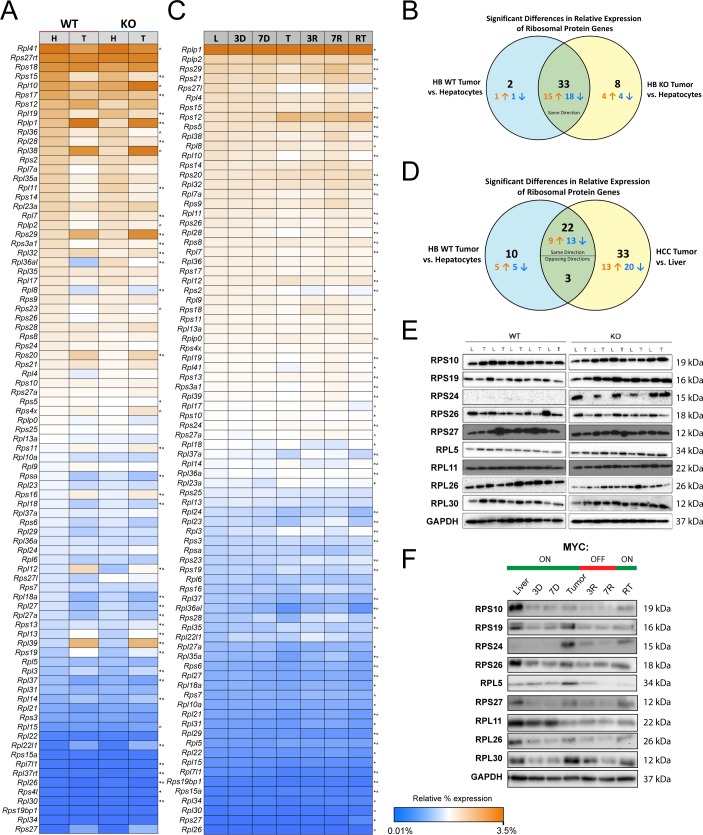
Relative RP transcript and protein levels differ in murine models of HB and HCC.(A) RP transcript abundance in hepatocytes (H) versus HB tumors (T). Heat maps are based on averaged RNA-seq data from 4–5 samples in each group with the most abundant transcripts being shown in orange and the least abundant transcripts being shown in blue, with the sum of all transcripts in each group equaling 100%. All transcript levels are expressed as a percent of total, displayed relative to those in WT hepatocytes and do not take into account the fact, as previously shown, that average RP transcript expression was increased 5.2-fold in HBs relative to hepatocytes [16] *: deregulated transcripts in WT tumors vs. WT hepatocytes, ^: deregulated transcripts in KO tumors vs. KO hepatocytes. (B) RP transcript deregulation among WT and KO hepatocytes and HBs. (C) Similar heat maps from livers or HCCs [13]. L: control livers. 3D and 7D: livers obtained 3 and 7 days after removing doxycycline to induce Myc expression. T: initial tumors. 3R and 7R: regressing tumors following doxycycline resumption for 3 or 7 days, respectively. Additional tumor-bearing mice were maintained on doxycycline for 2.5–3 months to allow for complete regression. Doxycycline removal in these mice led to development of recurrent tumors [12]. *: significant differences in relative expression compared to normal liver; ^: significant differences between recurrent tumor and liver (q-value < 0.05). Relative transcript abundance was expressed as described for panel A and compared with the relative abundance in control livers. (D) RP transcript discordances between HBs and HCCs. “Opposing” directionality occurred when an HB transcript’s direction of change relative to hepatocytes differed between WT and KO HBs. (E) Immunoblots of RPs in WT and KO livers (L) and HB tumors (T). (F) Immunoblots of RPs from livers, collected as described in (C).